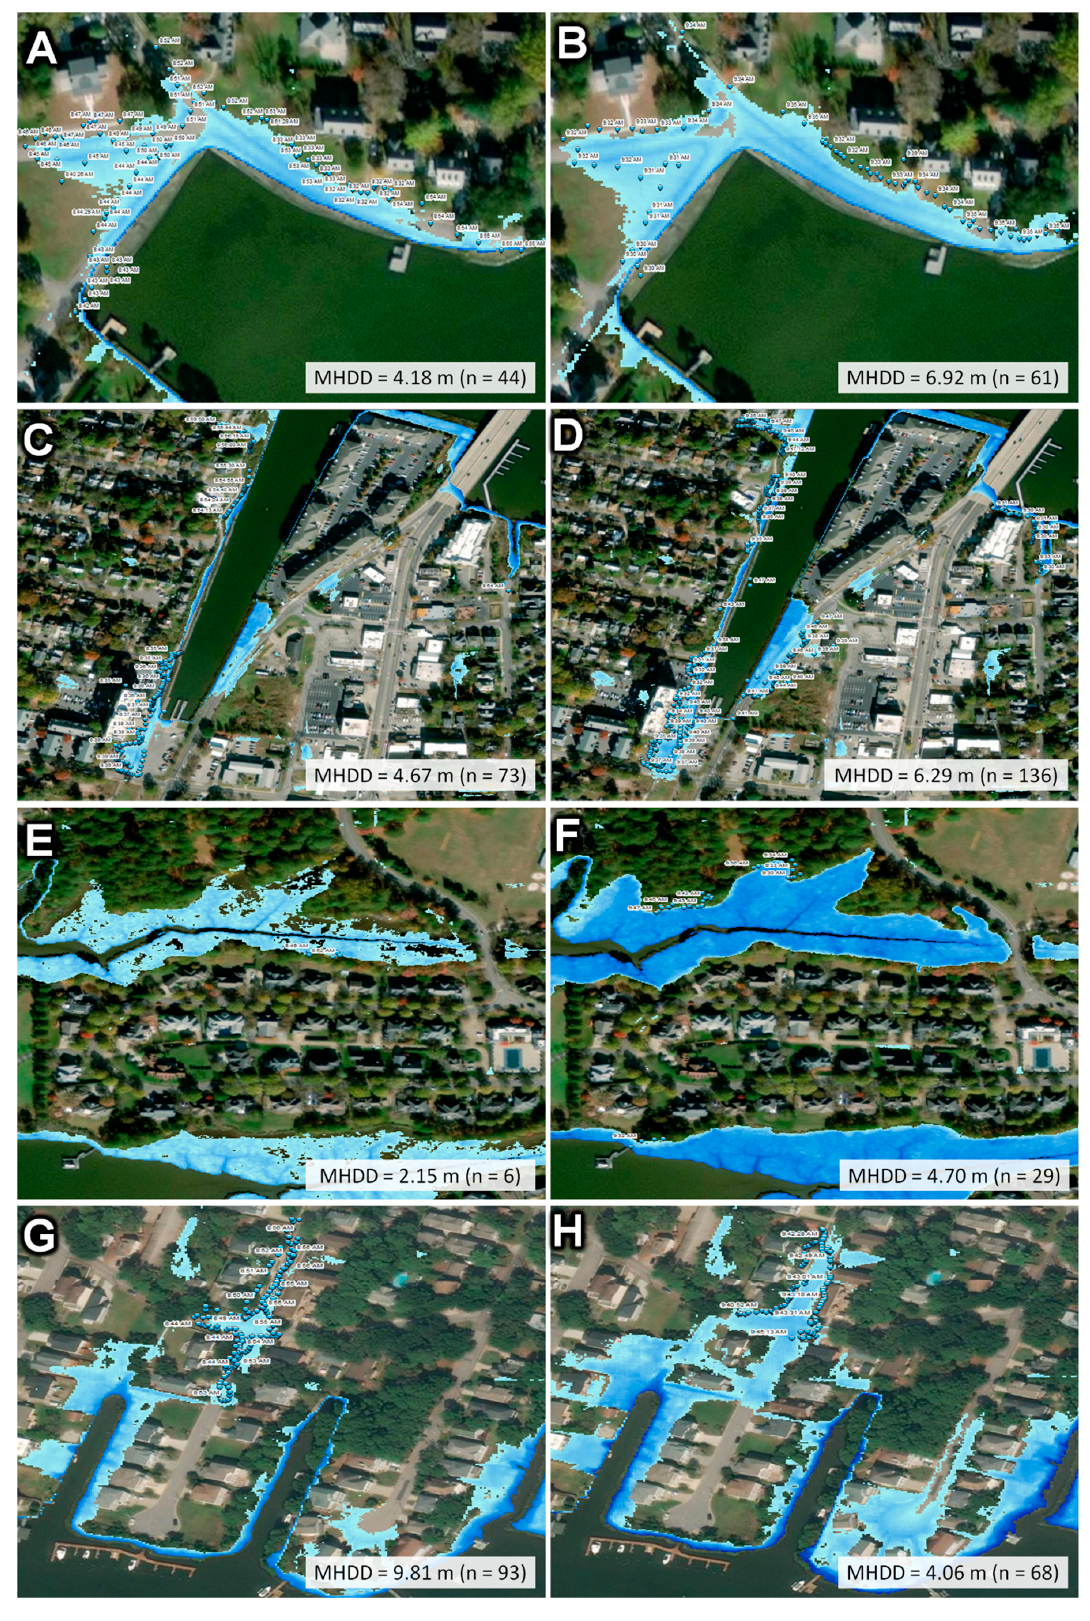
Figure 8. Model comparison of forecasts and data from 13:00 to 13:59 UTC at left, and 14:00 to 14:59 UTC used to show varying flooding conditions during the 2017 king tide at four sites ranging from residential, commercial, and industrial land uses throughout Norfolk, VA.